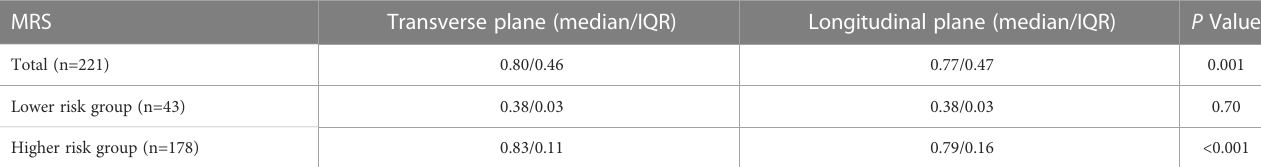
TABLE 2 Difference of MRS in transverse and longitudinal planes of